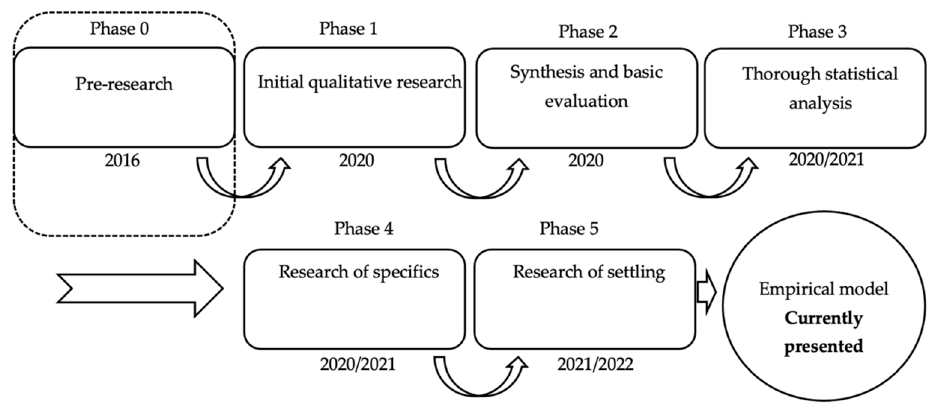
Figure 1. Research phases. Source: authors’ own processing based on [47].